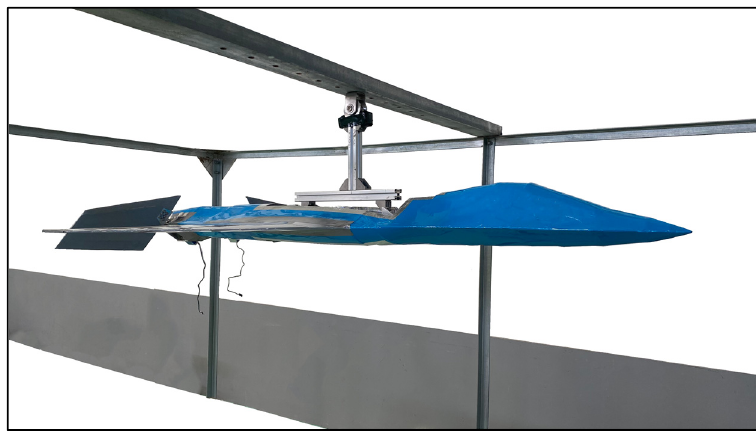
Figure 18. Moment of inertia measurement test using compound pendulum method.